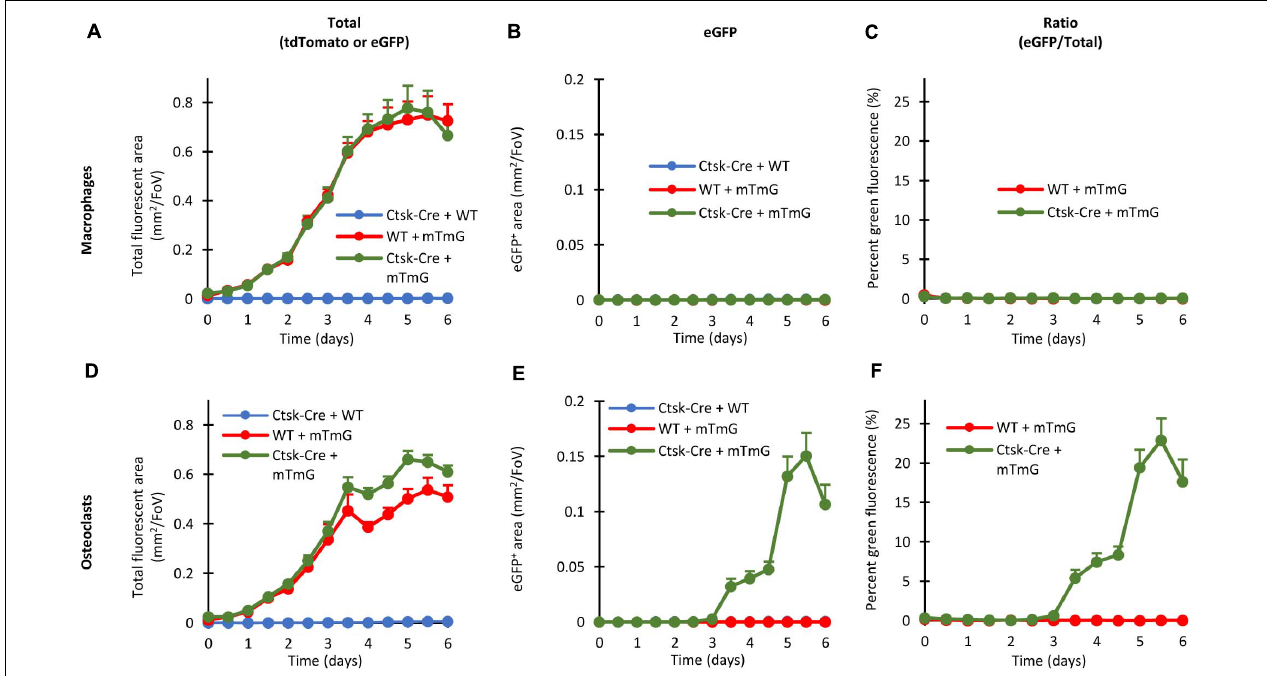
FIGURE 8 | Quantitative evaluation of the fluorescent signals in the FRAMCO1.2 assay. Quantitative evaluation of macrophage (A–C) and osteoclast (D–F) co-cultures of the indicated genotypes either showing the changes in total (tdTomato + eGFP) fluorescent area (A,D) , in green (eGFP) fluorescent area (B,E) or in the green area as percentage of the total fluorescent area (C,F) . All charts depict mean and SEM from 5 to 10 independent experiments.